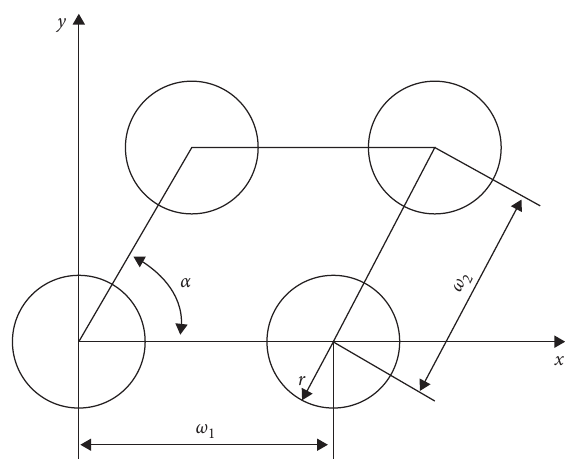
Figure 11: The geometric Vanin’s model for extremely reinforced PCMs medium.